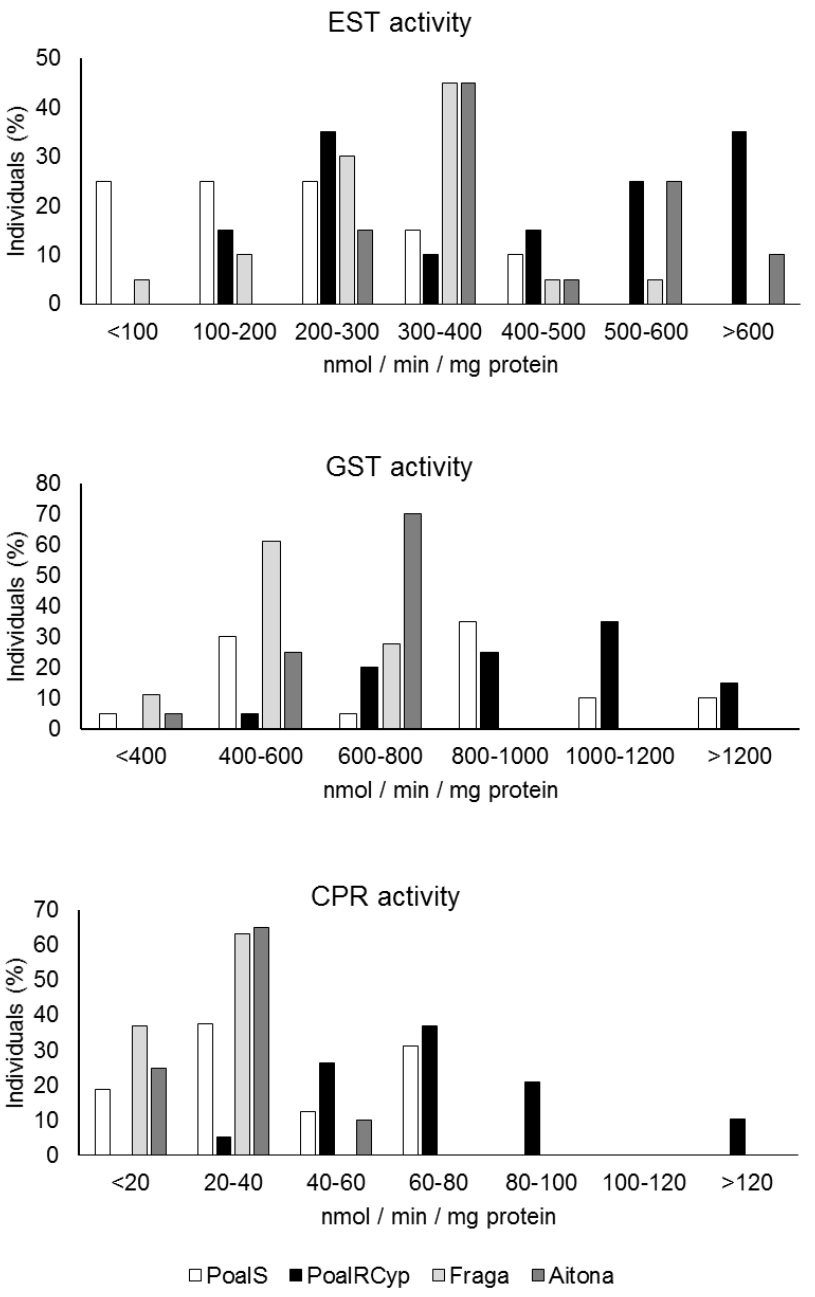
Figure 6. Frequency distribution of EST, GST and CPR activities (nmol of substrate · min − 1 · mg − 1 of protein) in psylla adults obtained from two laboratory-reared strains and two field populations collected in the Ebro Valley area (Spain). (Total number of insects tested, EST: n = 80; GST: n = 78; CPR: n = 74; n = 16–20 individuals per population).